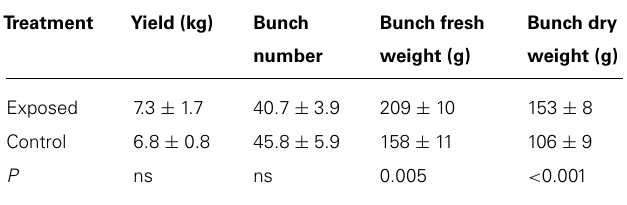
Table 1 |Yield and bunch characteristics (Mean ± SE, N = 12) of Semillon vines grown in exposed conditions and compared with those of protected vines covered by shade cloth over the 2008/09 growing